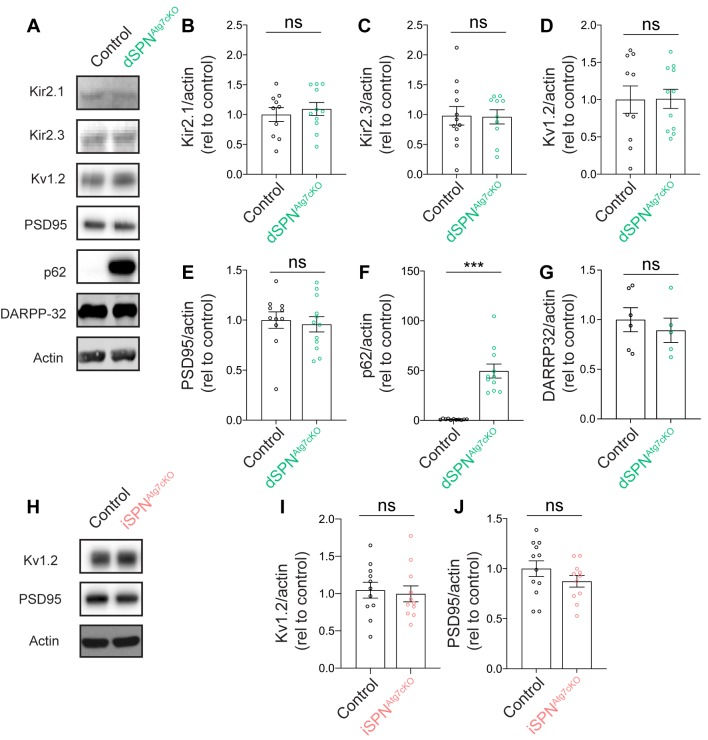
Loss of autophagy does not affect Kir2.1 expression in dSPNAtg7cKO mice.(A) Representative western blots from control or dSPNAtg7cKO mice. (B-G) Quantification of relative protein levels in control and dSPNAtg7cKO mice shows no significant difference between (B) Kir2.1 [dSPNCtrl: n = 10, dSPNAtg7cKO: n = 11; t19 = 0.5816, p = 0.5677], (C) Kir2.3 [dSPNCtrl: n = 12, dSPNAtg7cKO: n = 10; t20 = 0.08775, p = 0.9309], (D) Kv1.2 [dSPNCtrl: n = 10, dSPNAtg7cKO: n = 11; t19 = 0.04627, p = 0.9636], (E) PSD95 [dSPNCtrl: n = 11, dSPNAtg7cKO: n = 12; t21 = 0.3730, p = 0.7129], or (G) DARPP32 [dSPNCtrl: n = 6, dSPNAtg7cKO: n=5; t9 = 0.6178, p = 0.5520], but a significant increase in (F) p62 [dSPNCtrl: n = 11, dSPNAtg7cKO: n = 11; t20=6.936, p<0.0001]. (H) Representative western blots for Kv1.2 and PSD95 in control or iSPNAtg7cKO mice. (I-J) Quantification of Kv1.2 [iSPNCtrl: n = 11, iSPNAtg7cKO: n = 11; t20 = 0.3213, p = 0.7513] and PSD95 [iSPNCtrl: n = 12, iSPNAtg7cKO: n = 11; t21 = 1.264, p = 0.2202] shows no difference between control and iSPNAtg7cKO mice. Data analyzed by two-tailed unpaired t test. ns p>0.05, *** p<0.0001.Figure 5—figure supplement 1—source data 1.Source data for Figure 5—figure supplement 1.Figure 5—figure supplement 1—source data 2.Source Data for Figure 5—figure supplement 1 continued.